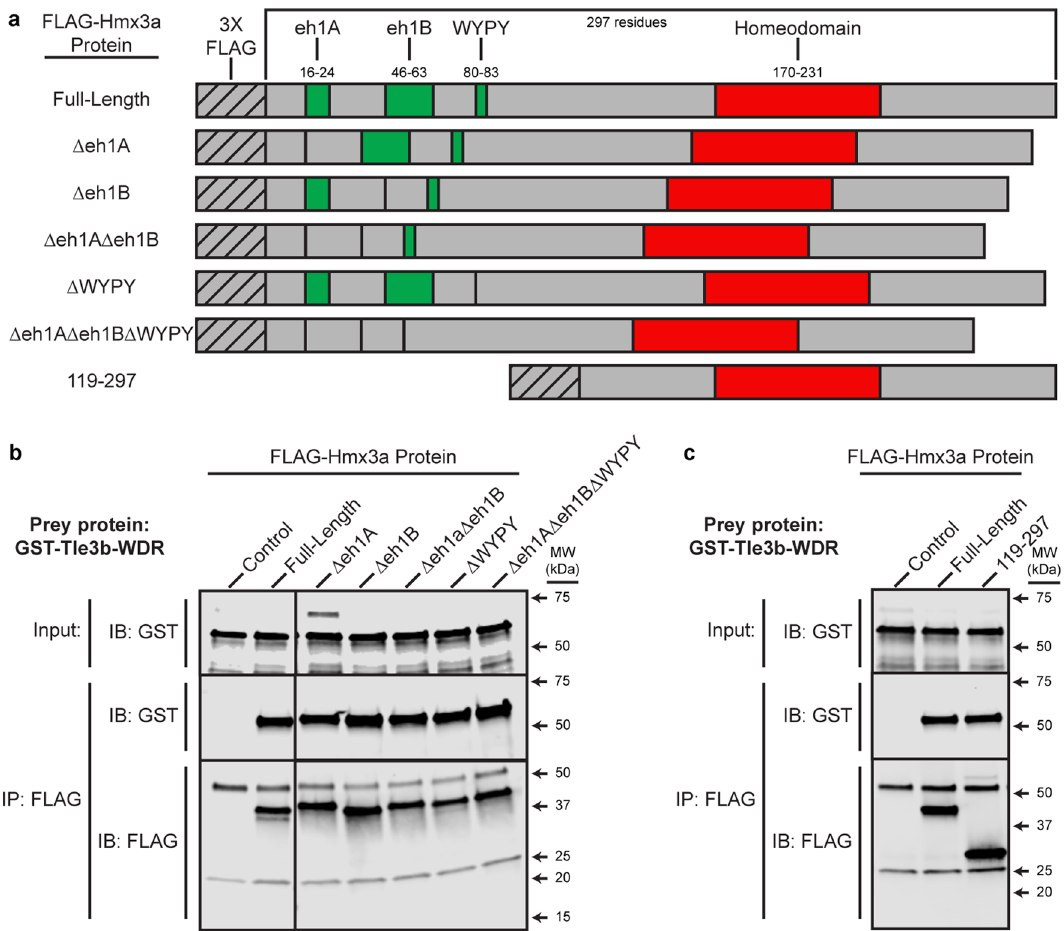
Figure 3. The WDR domain of Tle3b binds to the C-terminus of Hmx3a but not to any canonical Tle interaction motifs. ( a ) Schematics of FLAG-tagged Hmx3a constructs used in these experiments. eh1A, eh1B, and WYPY indicate predicted interaction motifs for Tle3b-WDR. Numbers (top) indicate residues encompassing annotated domains or (left-hand side, bottom row) included in the C-terminal construct. ( b , c ) The WDR domain of Tle3b was expressed as a GST-fusion protein, purified, and incubated with either a FLAG-Hmx3a-expressing embryo lysate or a stage-matched control lysate expressing no recombinant Hmx3a. Proteins were immunoprecipitated with an anti-FLAG antibody and separated by SDS-PAGE followed by transfer to a membrane and immunoblotting with anti-FLAG or anti-GST antibody. Top images in each panel show anti-GST immunoblot (IB) of 4% of input. Middle and bottom images in each panel show blots for GST and FLAG, respectively, of the immunoprecipitate (IB). MW is shown on the right-hand side. ( b ) Co-IPs with putative interaction motif deletion constructs. Blot images on each side of respective rows were from the same membrane and were processed identically for brightness/contrast. ( c ) Co-IP with carboxy-terminal Hmx3a construct. FLAG antibody heavy and light chains appear at just above 50 kDa and at 25 kDa, respectively in IP:FLAG;IB:FLAG fractions. Note that though it lacks 9 amino acids vs full-length Hmx3a, FLAG-Hmx3a- Δeh1A runs slightly above full-length Hmx3a (panel ( b ) IP:FLAG;IB:FLAG). A non-specific band, likely corresponding to the yolk protein Vitellogenin, is also visible above GST-Tle3b-WDR in the anti-GST input fraction of Δeh1A and, very slightly, in the control in panel ( b ). n = at least 2 for all experiments. Original blots are presented in Supplementary Fig.